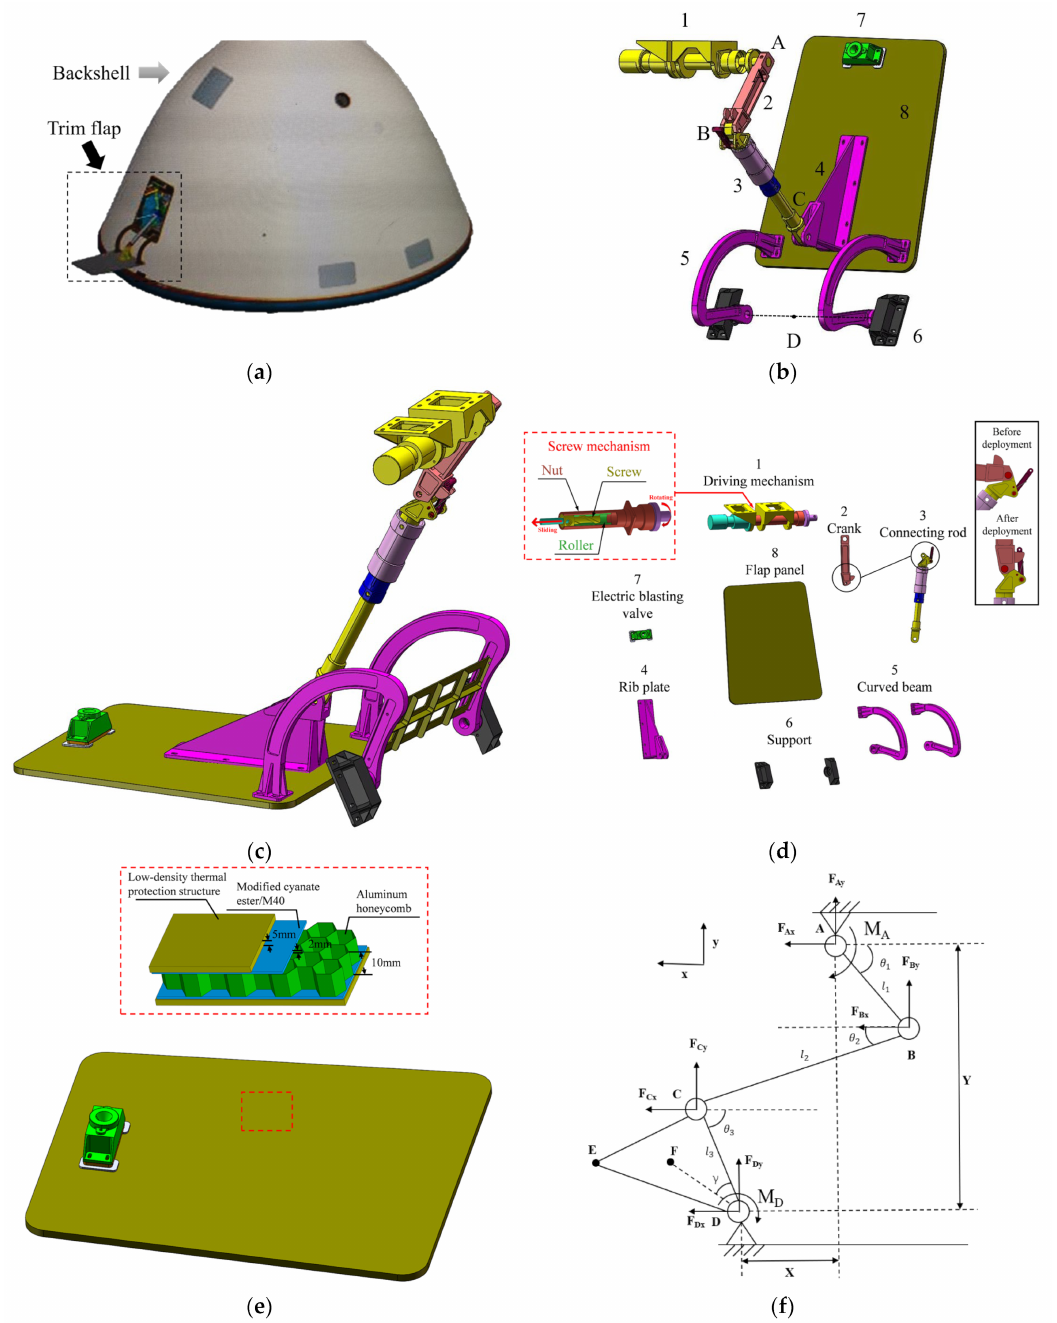
Figure 3. Geometry and theoretical model of the trim flap system: ( a ) Fully deployed configuration of the trim flap system mounted to the backshell; ( b ) Stowed configuration of the trim flap system; ( c ) Deployed status of the trim flap system; ( d ) Exploded view; ( e ) Detailed sandwich structure of flap panel; ( f ) Simplified planar two-dimensional theoretical